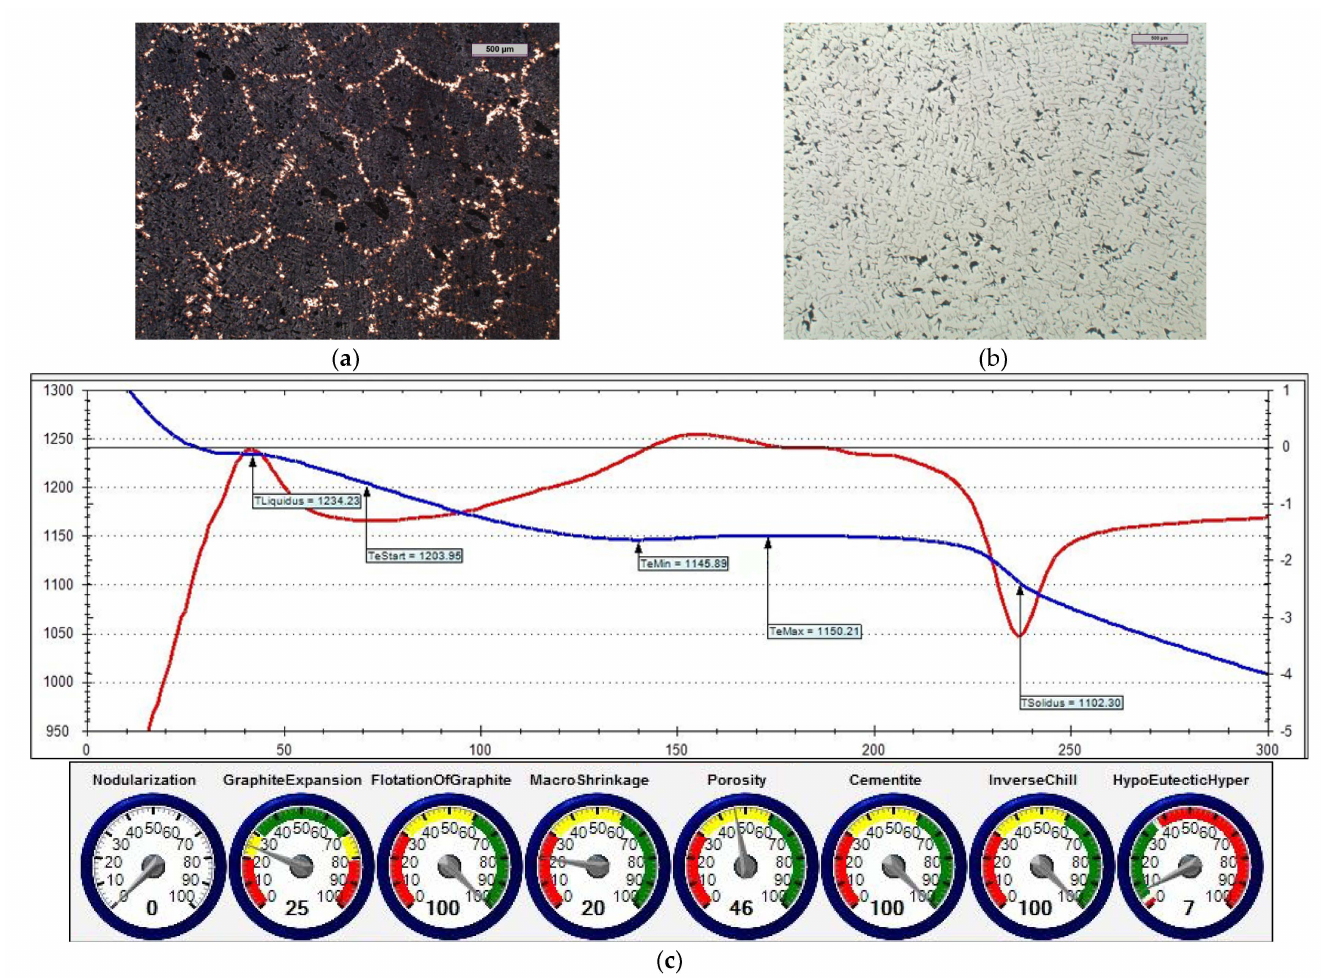
Figure 15. Grey cast iron (with 0.014% S content) and inoculated with 0.4% iron powder: ( a ) sample etched with Picral reagent; ( b ) non-etched sample; ( c ) changes in cast iron temperature (in time, sec.) during crystallisation and cooling of casting according to ITACA